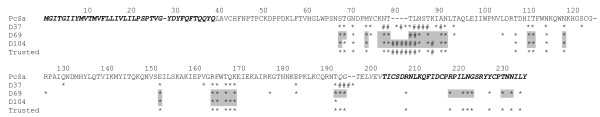
Maloideae positively selected amino acid sites. The Pyrus communis Sa sequence (PcSa) is the reference. D37 - the 37 sequence dataset of Vieira et al. [12]; D69 - the 69 sequence dataset (complete sequences); D104 - the 104 sequence dataset. The region that is not analysed when using the D37 and the D104 datasets is shown in bold and italics, respectively. * - non-gapped positively selected amino acid sites; # - gapped positively selected amino acid sites. In gray are shown the amino acids that are identified as positively selected when using OmegaMap only. It should be noted that, the alignment used in Vieira et al. [12] is not the same as that used for the D69 and D104 datasets.